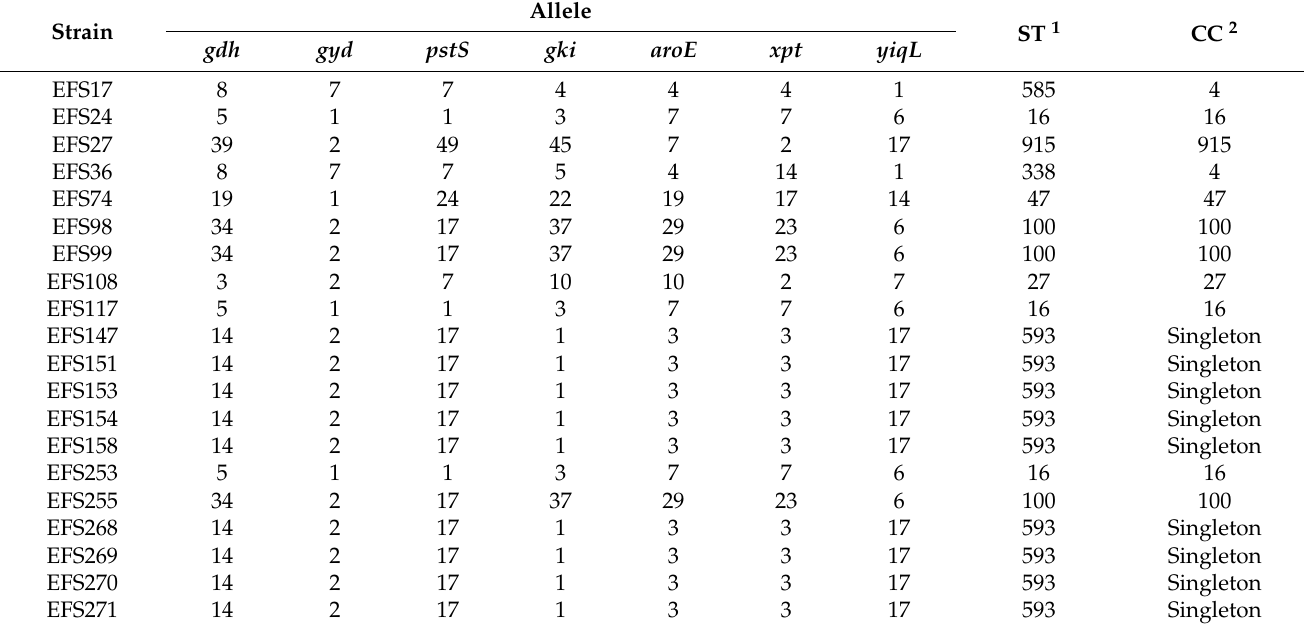
Table 3. MLST analysis of enterococci strains harboring phenicol-oxazolidinone resistance genes.